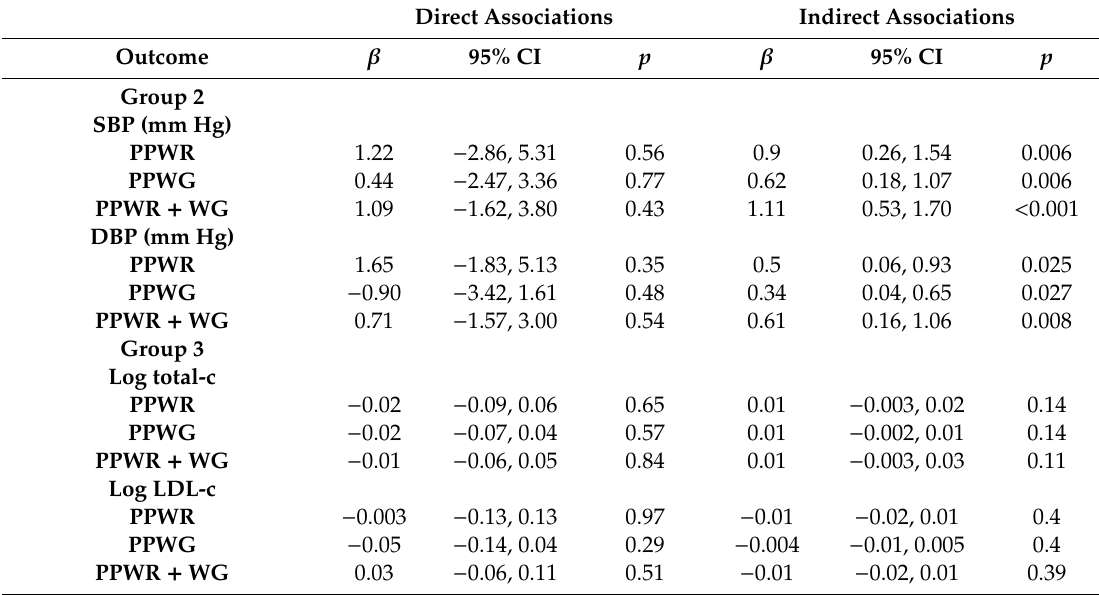
Table 3. Path coe ffi cients and 95% CI for the association between patterns of weight change one year after delivery with SBP, DBP, total-c, and LDL-c at six years postpartum. Direct Associations Indirect